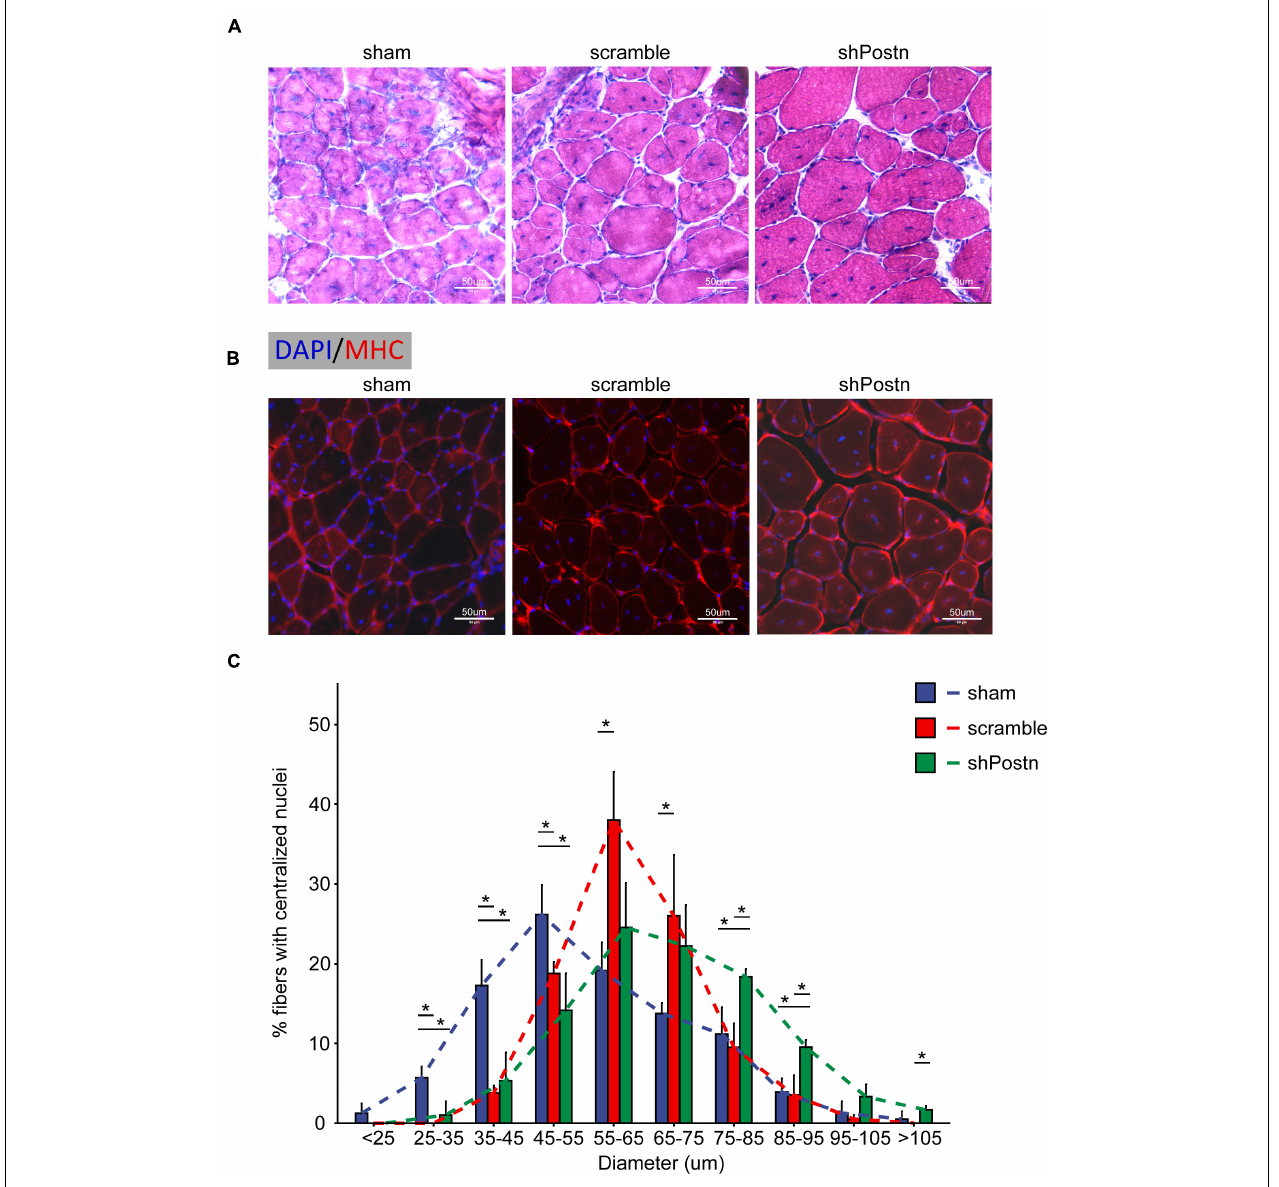
FIGURE 7 | Knockdown improved the myogenic ability of DM1 myoblasts in vivo . (A) H&E staining of cross-sections of the TA muscles from the sham, scramble, and Postn knockdown groups. (B) Immunostaining against MHC of cross-sections of the TA muscles from the sham, scramble, and Postn knockdown groups. (C) The diameters of myofibers of the TA muscles from the sham, scramble control, and Postn knockdown groups. S ham, PBS; scramble, scramble control DM1 myoblasts; and shPostn, Postn knockdown DM1 myoblasts; * P <